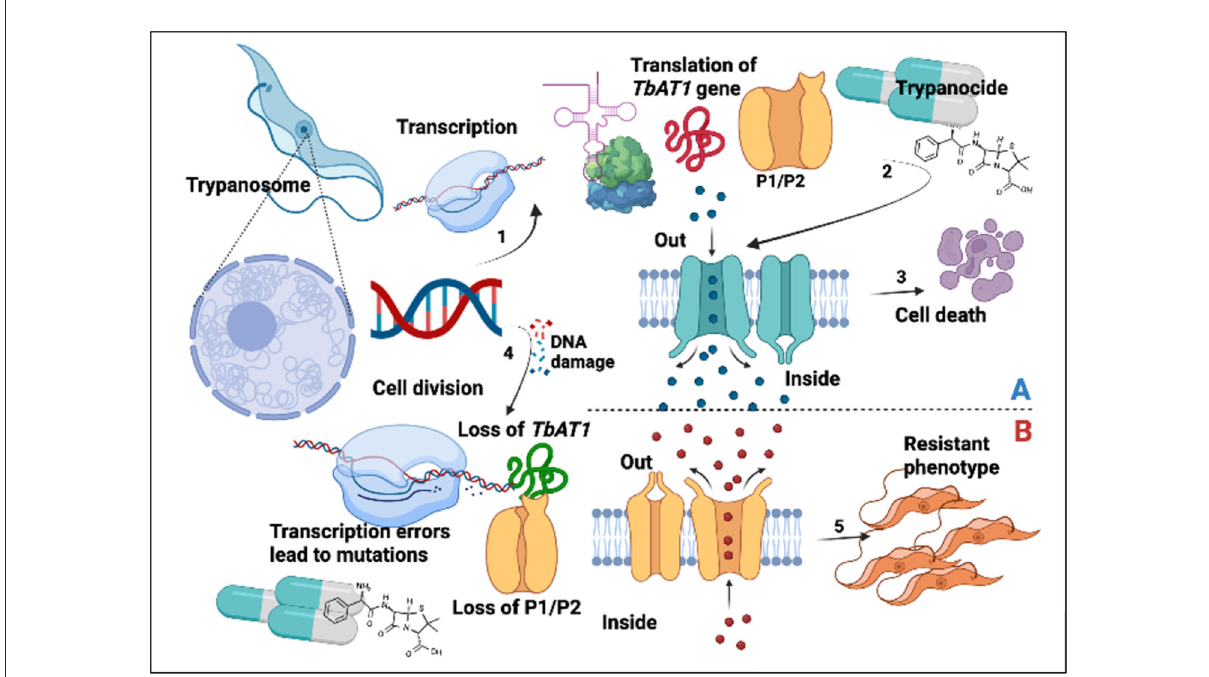
FIGURE7 Trypanocide activity is favored by a healthy phenotype (A) . (1) Gene expression leading to production of Tb AT1/P2. Trypanocides (2) move into the cell to exert their effects leading to cell death (3). Resistant phenotype (B) . This arises following DNA damage (4), transcription errors,